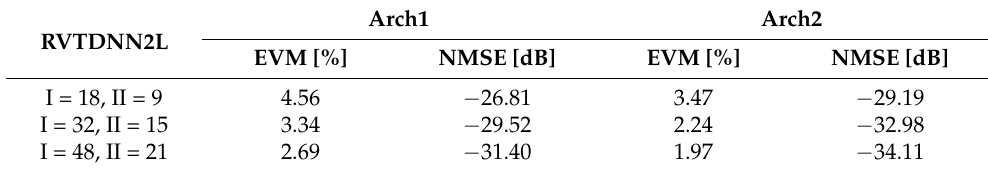
Table 5. Performance of RVTDNN2L DPD for 64 × 64 MU FC HBF MIMO system—user